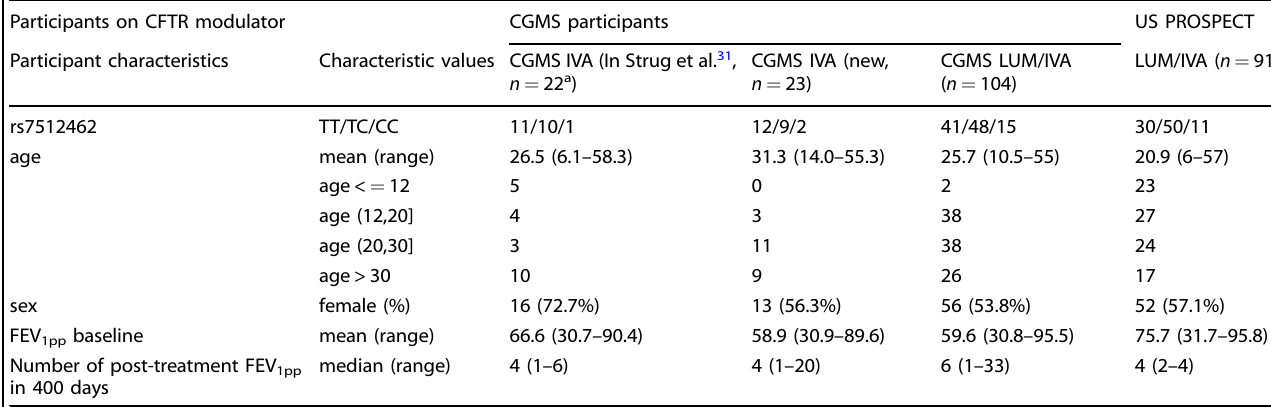
Table 1. Characteristics of participants included for response to CFTR modulators from the CGMS and US PROSPECT